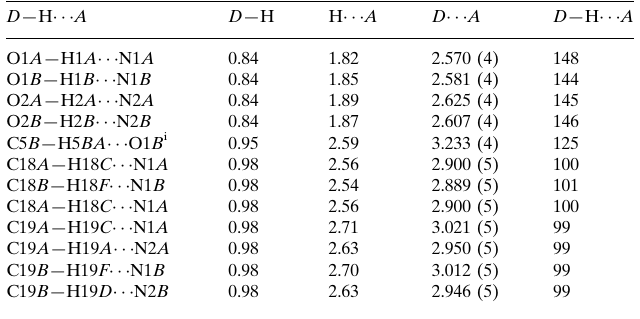
Hydrogen-bond geometry (A˚ , (cid:2)